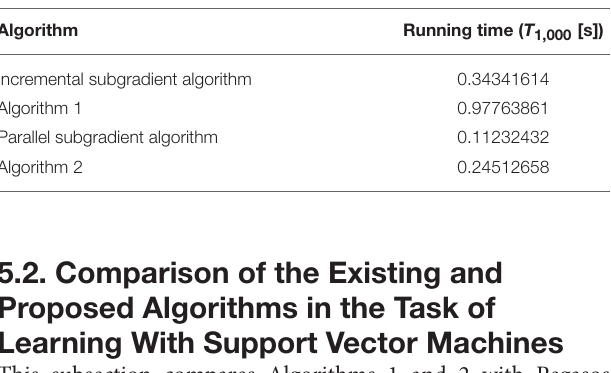
TABLE 1 | Running time of each algorithm in solving the test problem 1. TABLE 2 | Datasets used in our experiments.